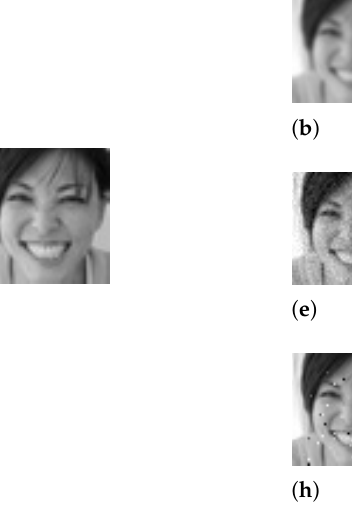
Figure 1. Illustration of sample distorted images used in our study: ( a ) represents an original image from the FER-2013 dataset; ( b – d ) are its GB versions; ( e – g ) the GN versions; and ( h – j ) the SP versions (at low, medium, and high levels,